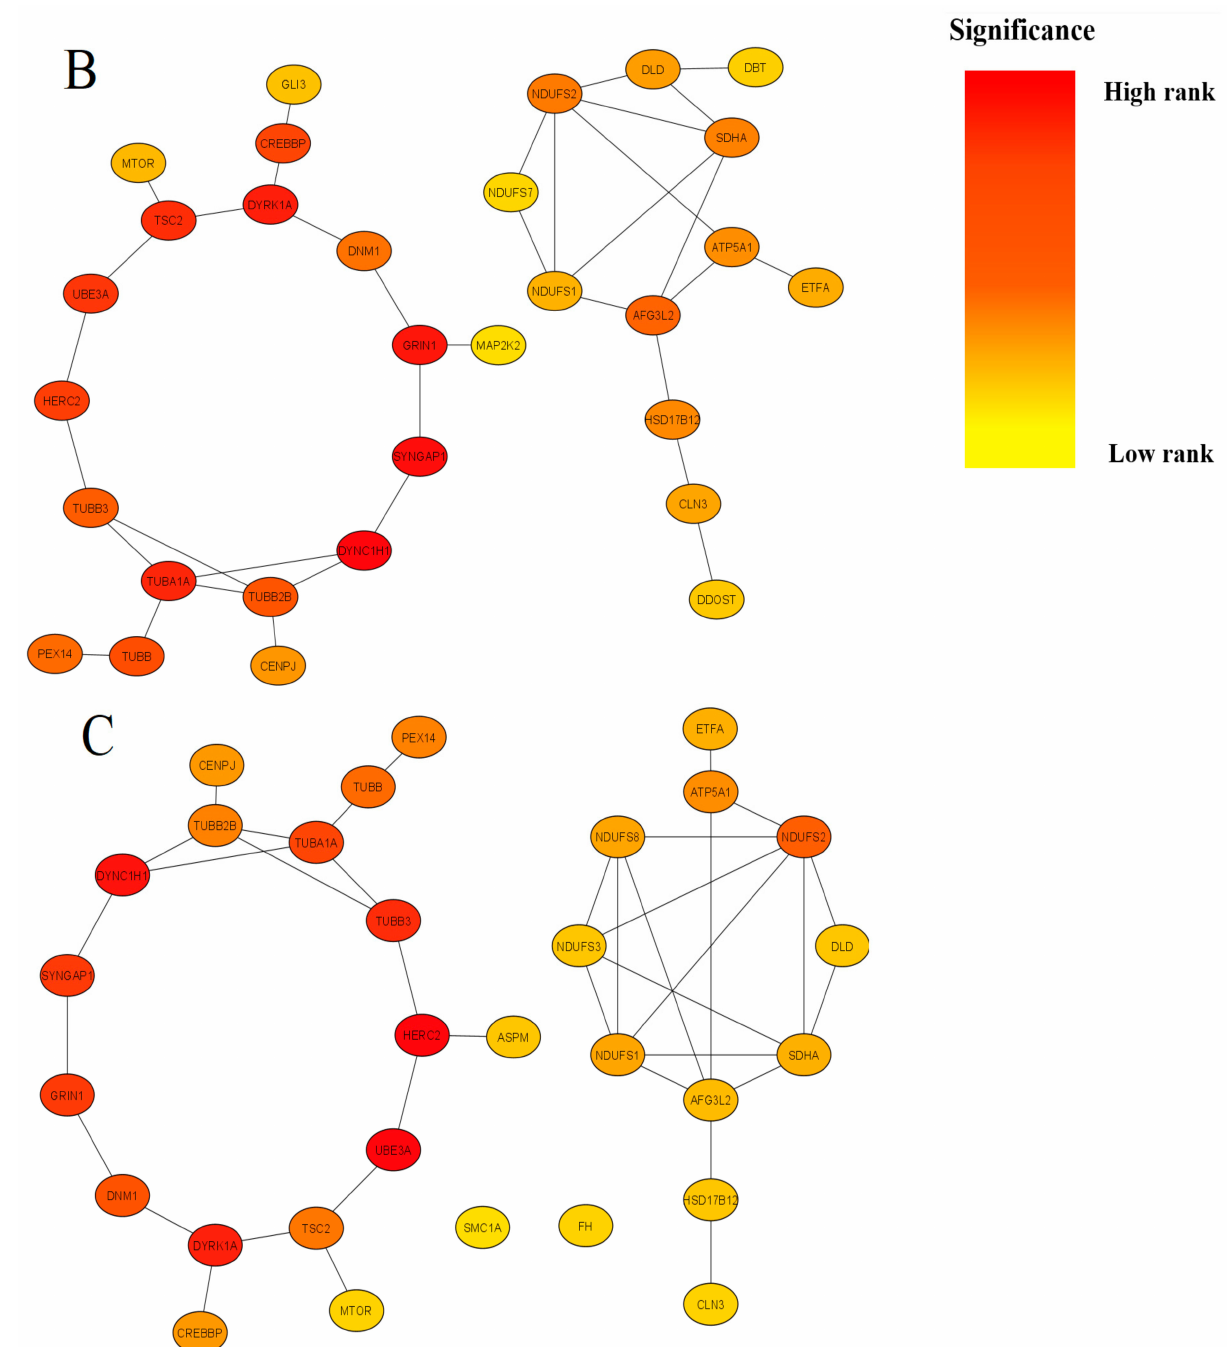
Figure 2. Summary of modules extracted from the global protein-protein interaction (PPI) network based on their Betweenness centrality (Panel ( A ), 30 nodes and 35 edges), Stress centrality (Panel ( B ), 30 nodes and 36 edges) and BottleNeck centrality (Panel ( C ), 30 nodes and 38 edges). Colors denote significance (high-ranked modules = red, low-ranked modules = yellow). For interpretation of the references to color in this figure legend, the reader is referred to the web version of this